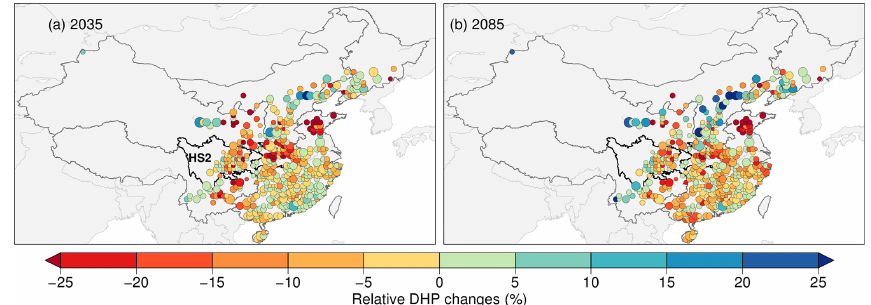
Figure 6. Medians of relative DHP changes for present reservoirs in China across the ensemble of GCM-GHM combinations for 2020– 2050 (a) and for 2070–2099 (b) under RCP8.5. Black lines depict the hotspot region HS2; i.e., Sichuan (including Chongqing) and Hubei provinces. Circle size is determined according to the logarithm of reservoir storage capacity.